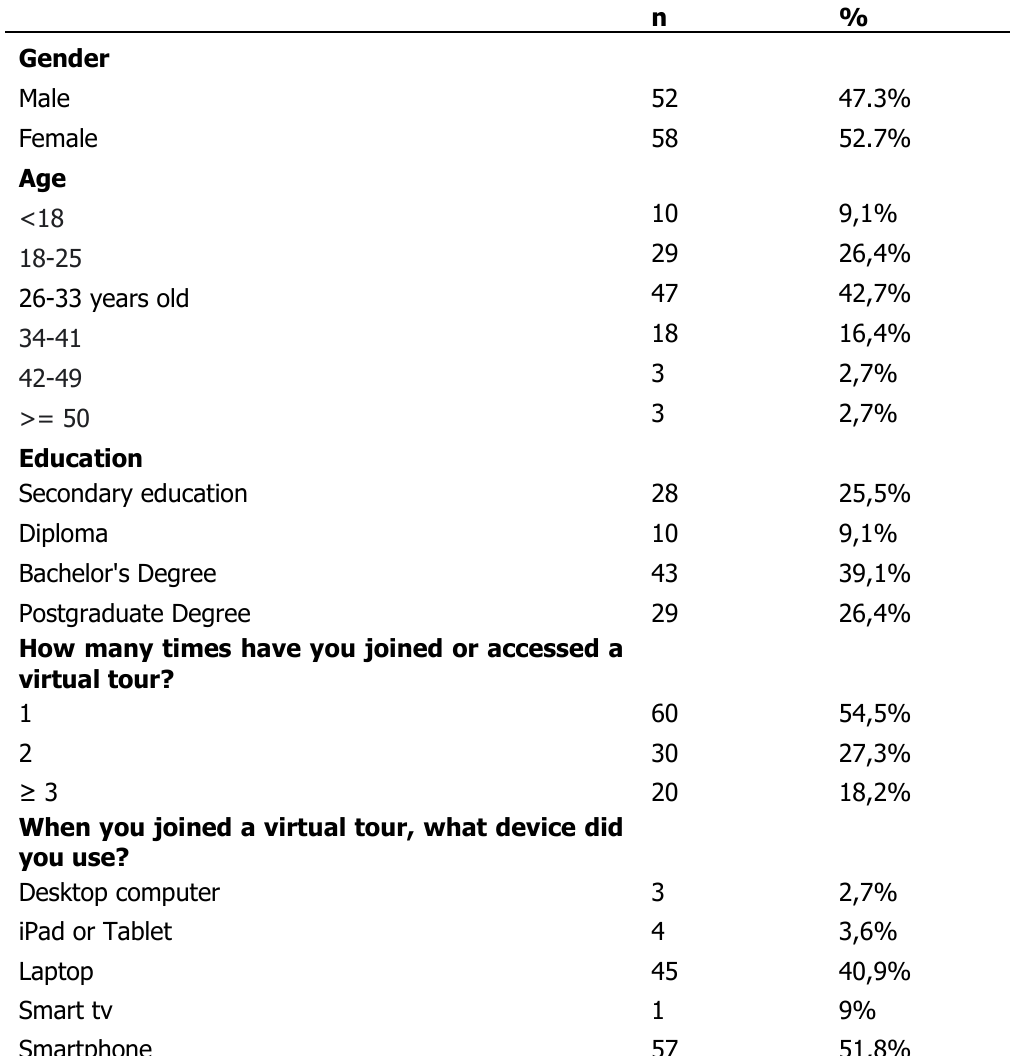
Table 2 . Profile of Respondents (Total N= 110